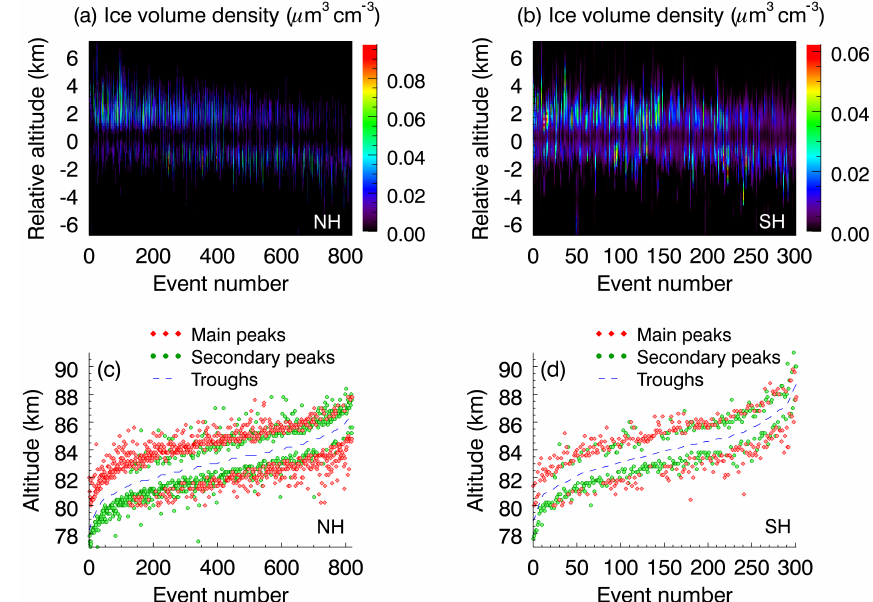
Figure 2. All events with double-layer structure observed by SOFIE from 2007 to 2014. The ice volume density ( V ice ) profiles are shown for (a) NH and (b) SH respectively, and aligned to the troughs between two peaks. The event number is arranged according to increasing altitude of the trough. The real altitudes for peaks (diamonds and circles) and troughs (dashed lines) are shown in (c) and (d) . The red diamonds represent the main peak altitudes with the greatest V ice , while the green circles are the secondary peak altitudes.